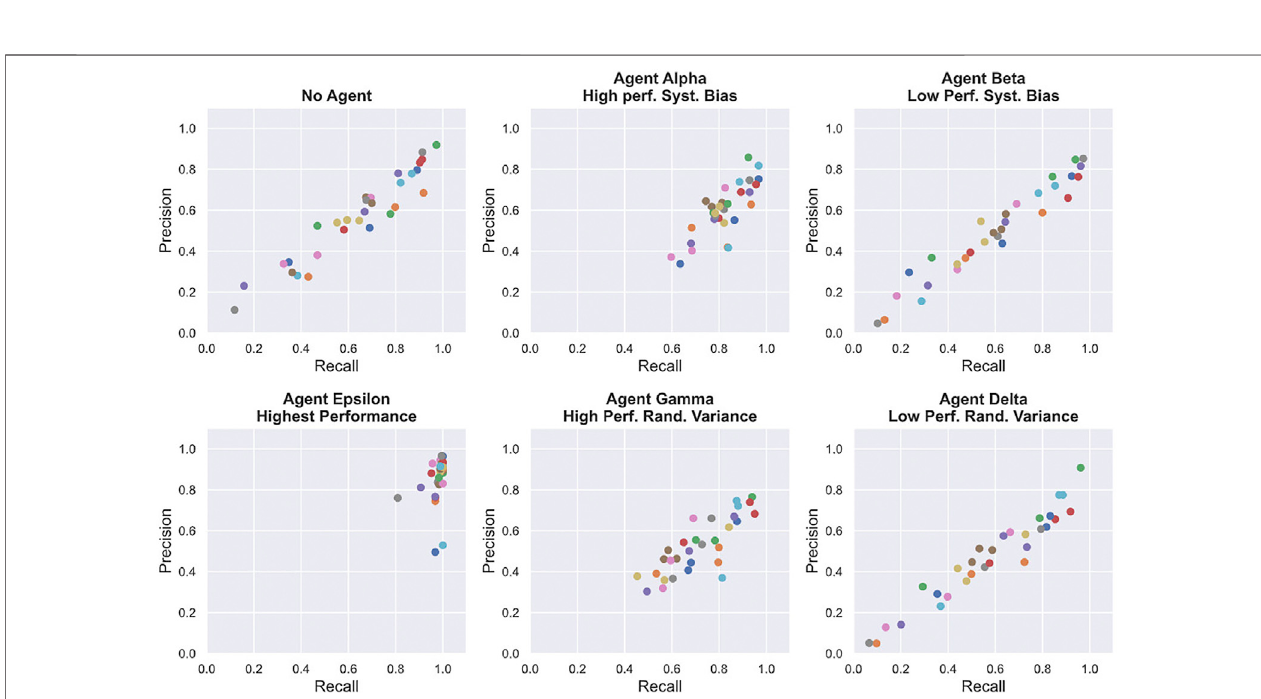
FIGURE 8 | Average Raw NASA TLX ratings for each sessions with agents. Higher scores indicate greater cognitive loads.